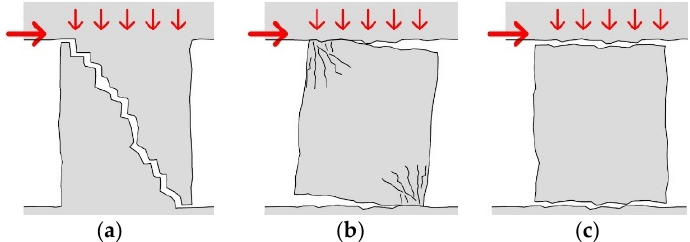
Figure 1. Typical failure modes of masonry elements under in-plane loading: ( a ) diagonal cracking, ( b ) bending with rocking and/or toe crushing and ( c ) shear sliding.